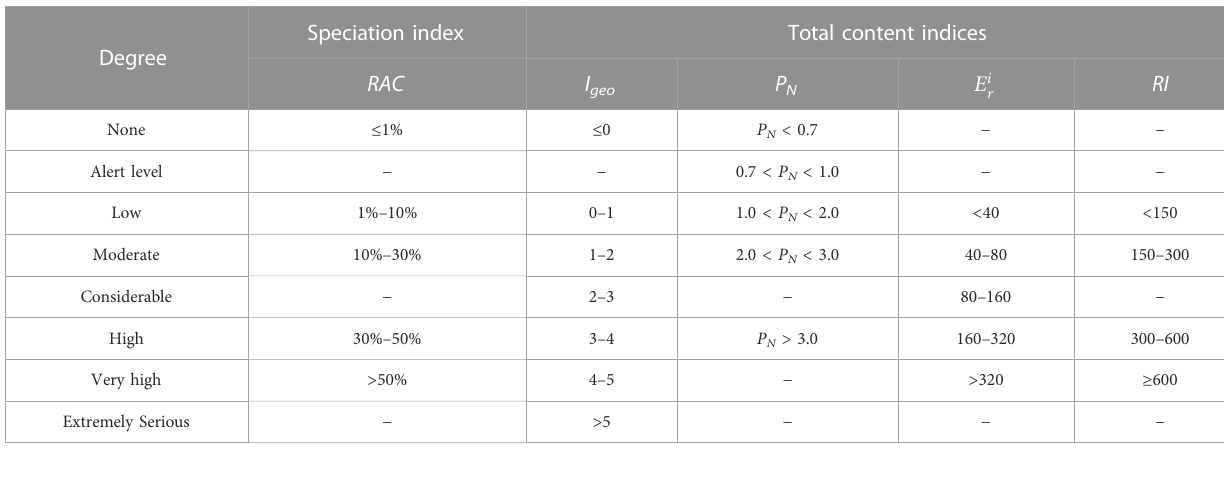
TABLE 1 The degrees of contamination and ecological